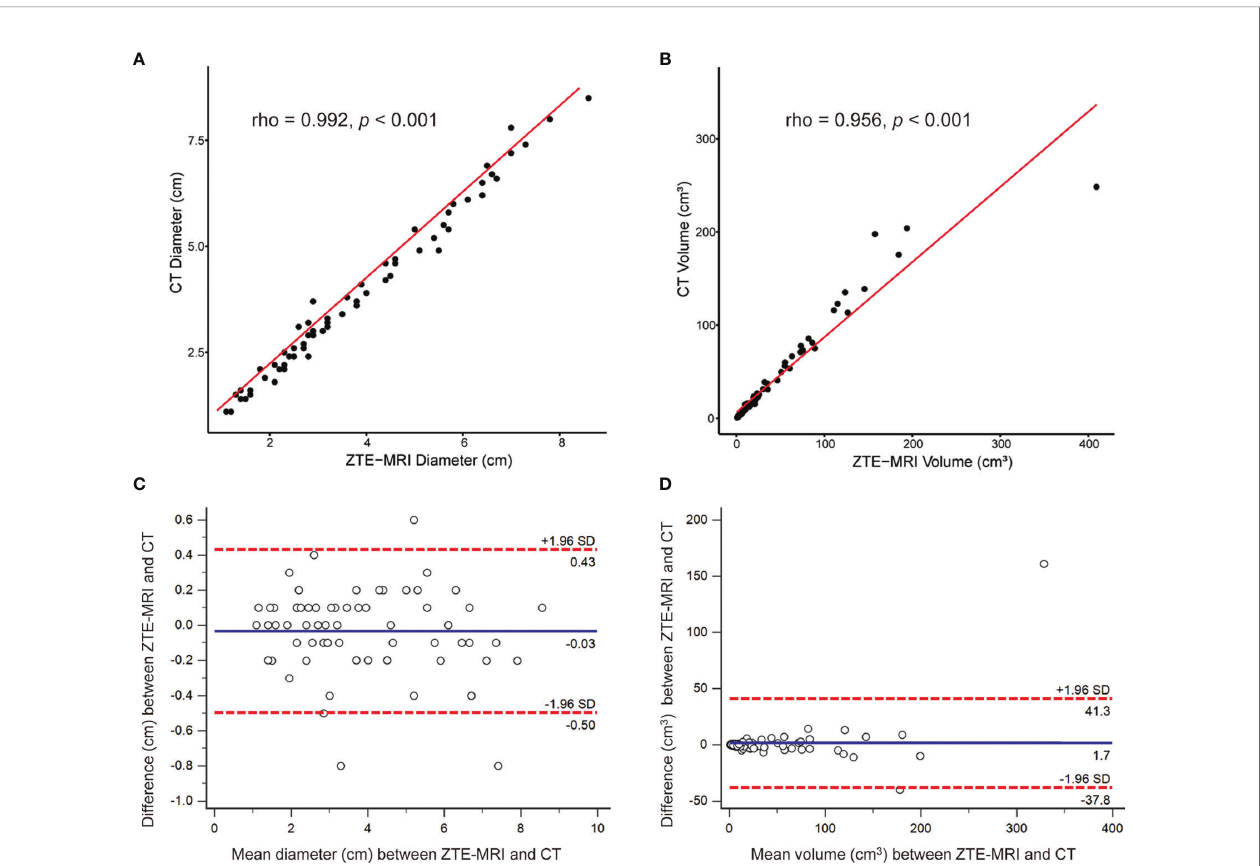
FIGURE 5 | Inter-modality correlation and agreement for lesion measurements. Scatter plots demonstrat the correlations between ZTE-MRI and CT for diameter (A) and volume (B) . Bland – Altman plots show the inter-modality agreement between ZTE-MRI and CT for diameter (C) and volume (D) .